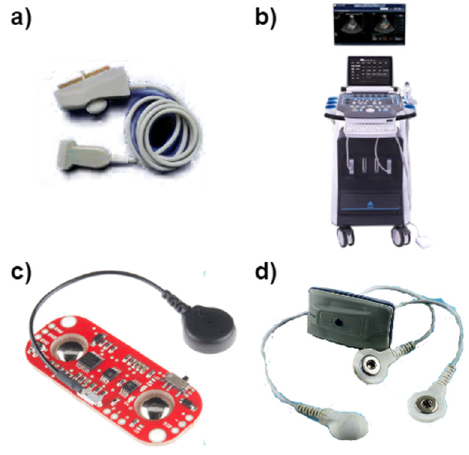
Figure 2. Photographs of biosensing devices ( a ) ultrasound probe for sonomyography, ( b ) ultrasound system for elastography, ( c ) surface electromyography sensor, and ( d ) mechanomyography